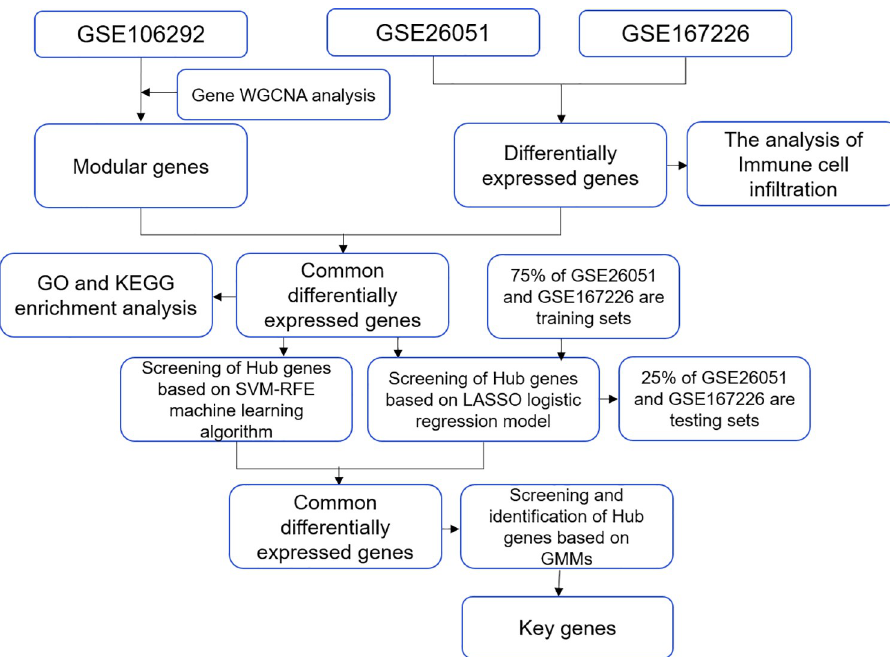
Fig 1. Flowchart of this study. The following datasets were used for the identification of potential diagnostic genes and mechanisms associated with the development of sepsis: GSE106292, GSE26051, GSE167226. https://doi.org/10.1371/journal.pone.0259475.g001 standard deviation > 0.5. Based on the proximity matrix β = 16, we made the gene distribution conform to the scale-free network, sample tree and soft threshold estimation according to the connectivity degree. We set the vertical axis as the scale-free topology fitting index R^2 (the values in the SFT.R.Sq column in the statistical results) (Fig 3A) and the average connectivity of the network (Fig 3B). According to the negative correlation between k and p(k) (correlation